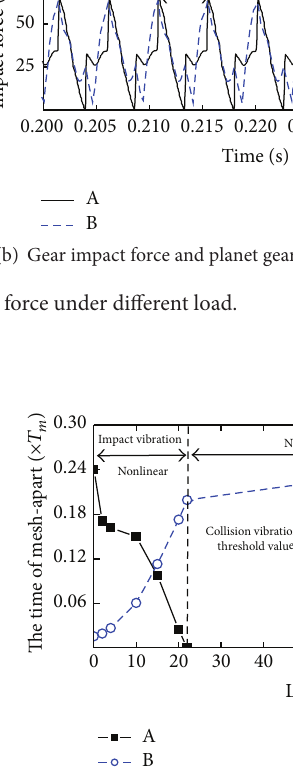
Figure 10: The effect of the load on gear vibroimpact